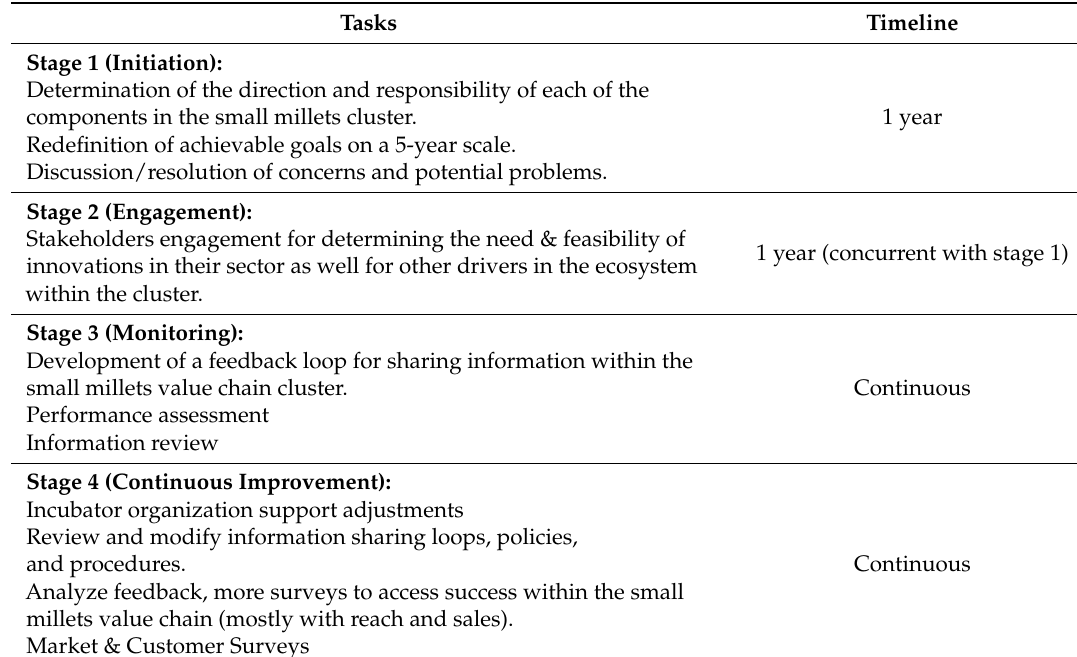
Table 1. An implementation guide for executing the open innovation concept in the small millets value